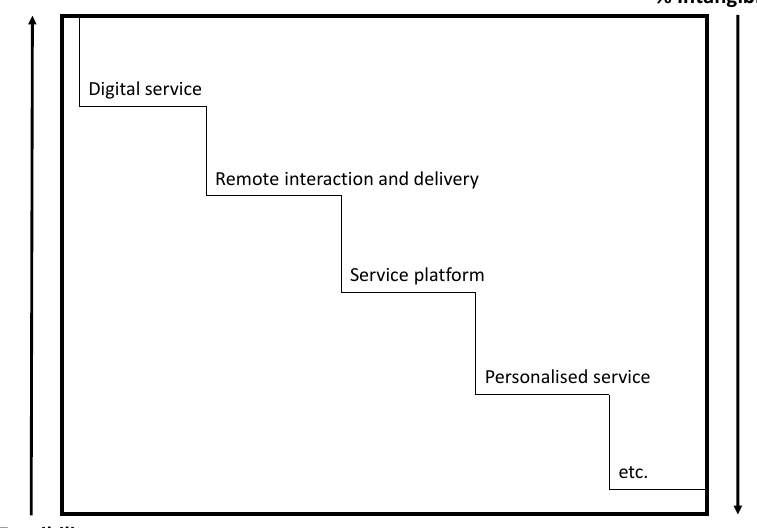
Figure 11. Radical servitization strategy.